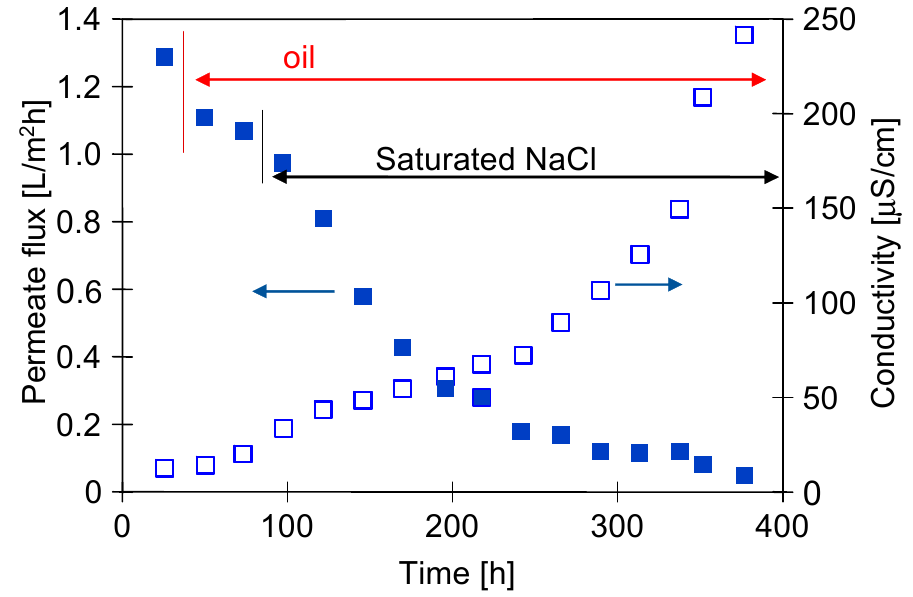
Figure 3. MD process of NaCl solutions contaminated with oil (80 mg/L). T F = 333 K, Module M1—membrane V8.